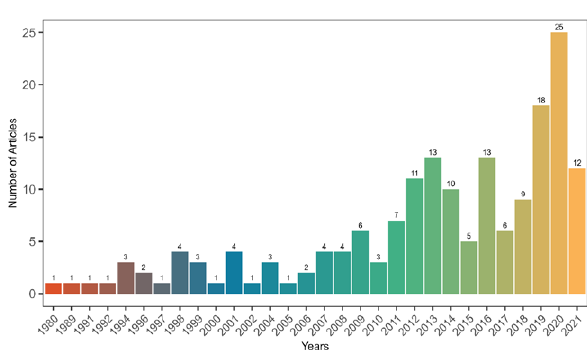
Figure 2. Number of published articles in AI